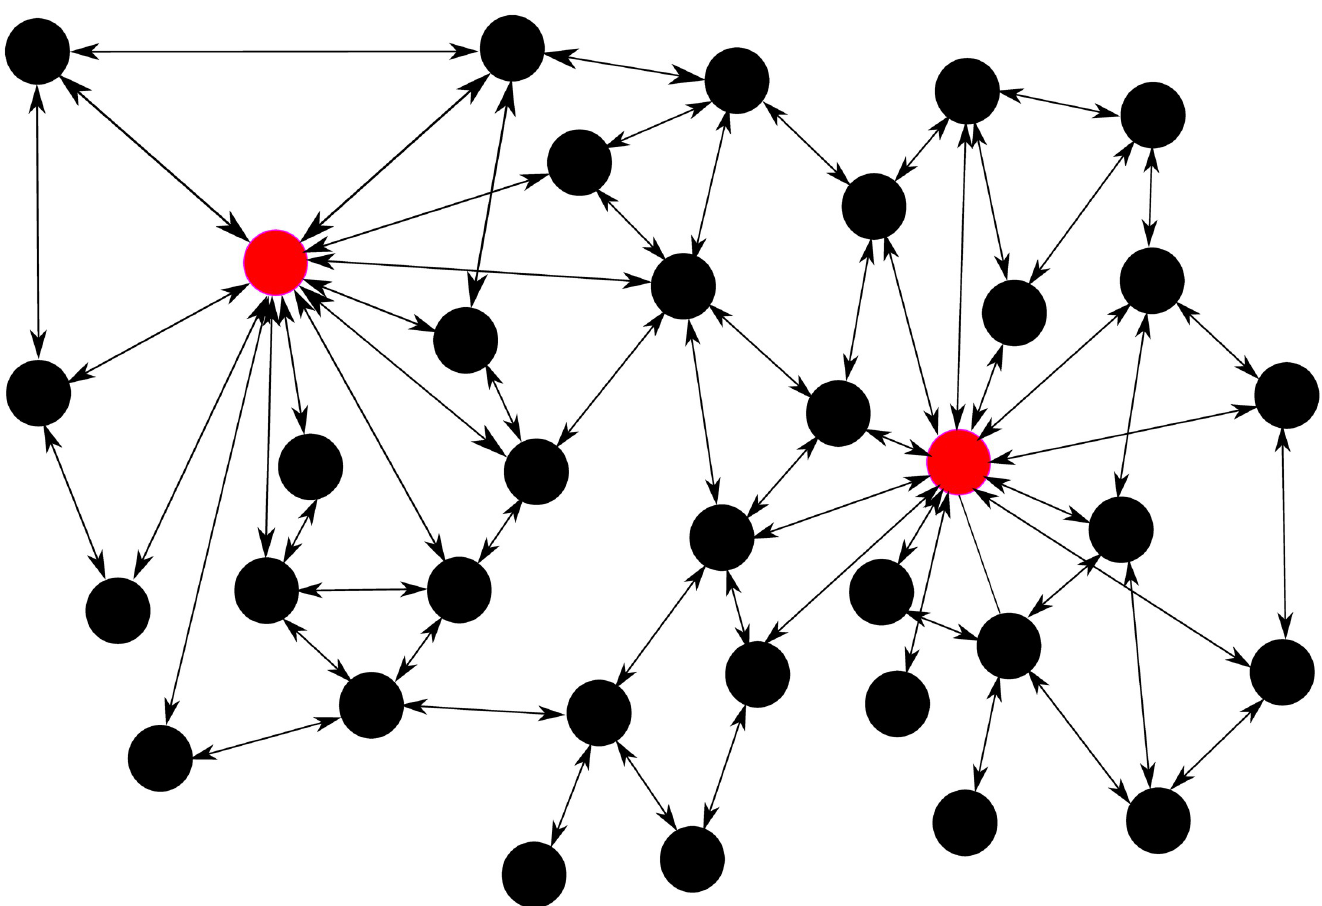
Fig 1. Pictorial representation of contact hubs: Superspreaders (in red) have a much higher number of contacts than the average individuals (in black). Arrows represent social contacts able to transmit the virus.